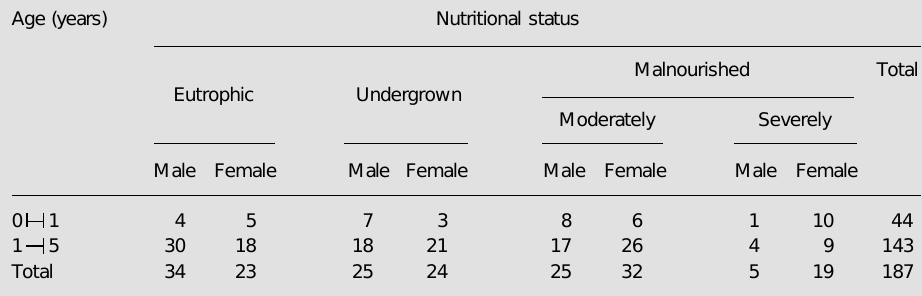
Table 1 - Nutritional status of 187 children who participated in the study. Nutritional status was assigned on the basis of weight and height for age and sex using National Center for Health Statistics (12). Age (years) Nutritional status Malnourished Undergrown